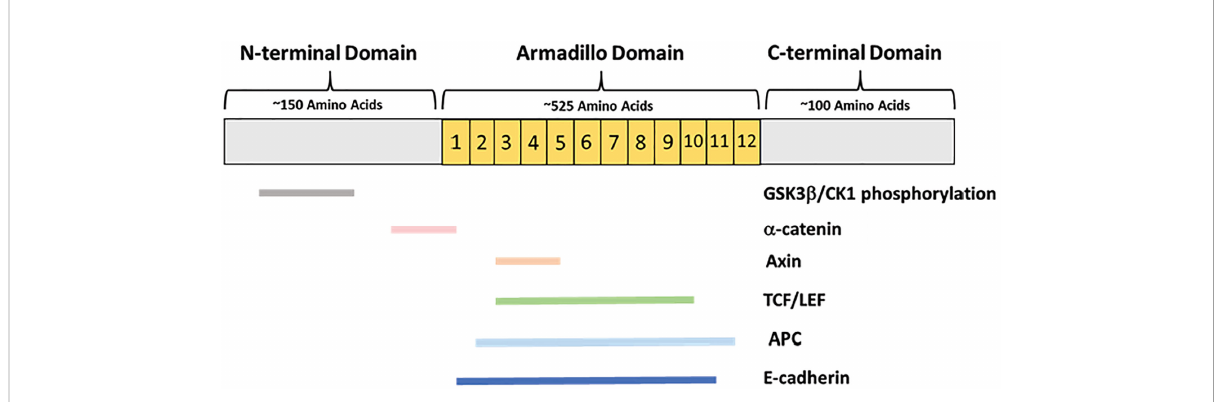
FIGURE 2 b -catenin protein domains and primary binding partners. b -catenin is comprised of an approximately 150-amino-acid N-terminal domain, a 525-amino acid central Armadillo domain containing 12 Arm repeats, and an approximately 100-amino acid C-terminal domain. The N-terminus is the site of GSK3 b and CK1 phosphorylation, as well as partial a -catenin binding. The Armadillo domain contains overlapping binding sites for a -catenin, E-cadherin, Axin, APC, and the TCF/LEF transcription